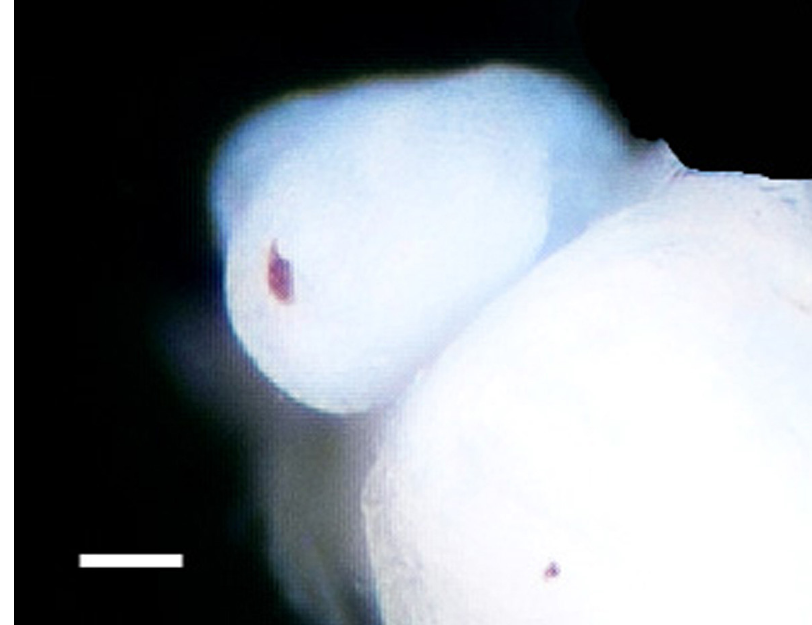
Fig. 18. Penis of H. lozekiana sp. nov. Frontal view showing stylet. Scale bar = 50